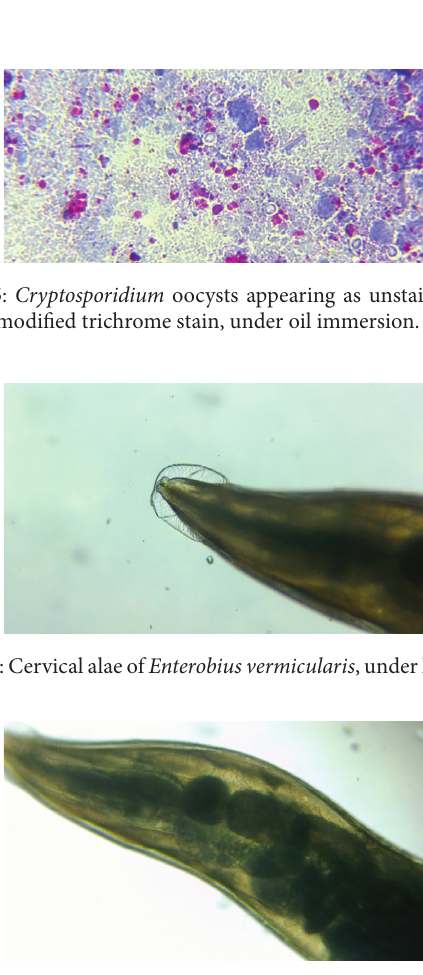
Figure7:Doublebulboesophagusof Enterobiusvermicularis ,under low power.